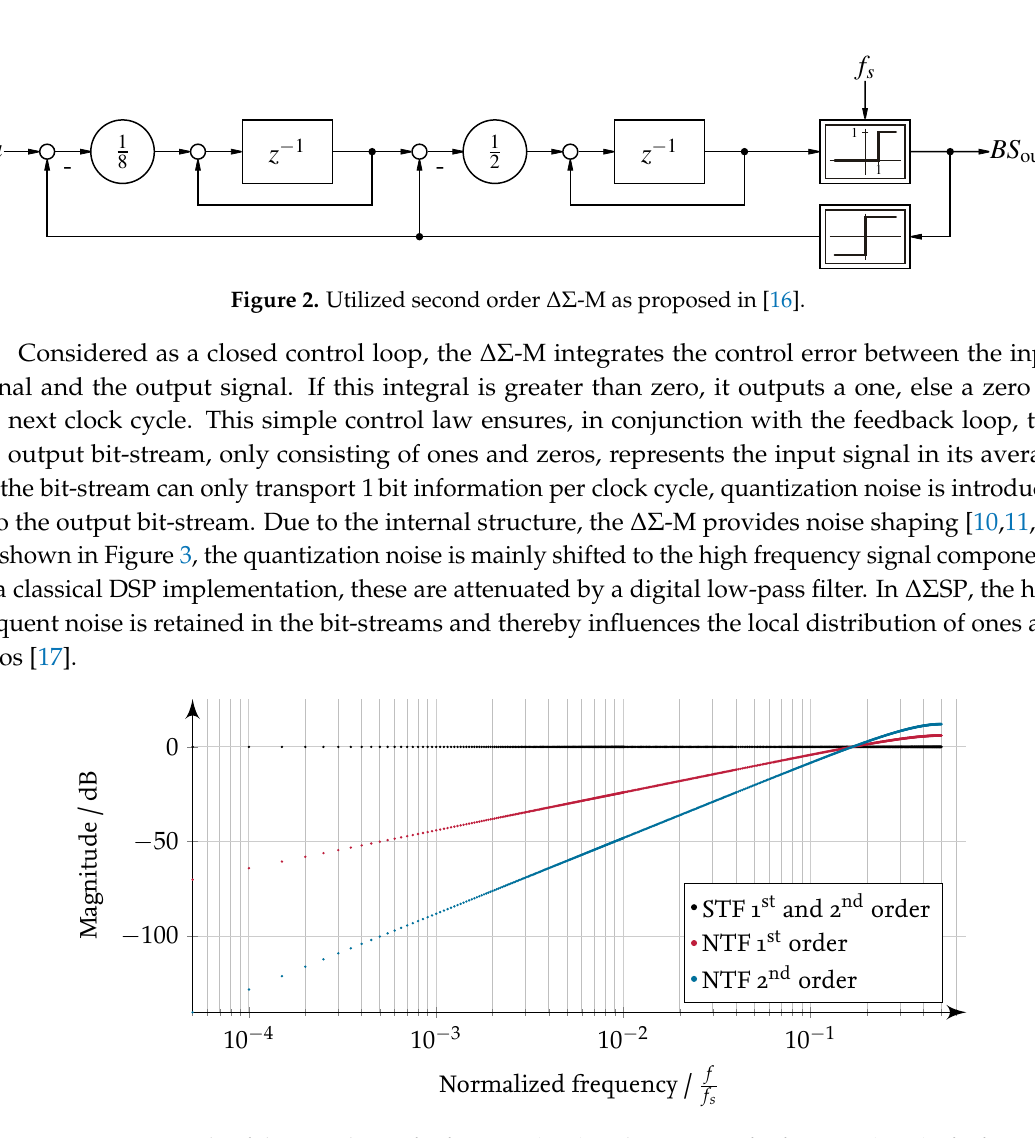
Figure 3. Magnitude of the signal transfer function (STF) and noise transfer function (NTF) of a first order and a second order ∆Σ -M [11] over the frequency related to the sampling frequency ( f s